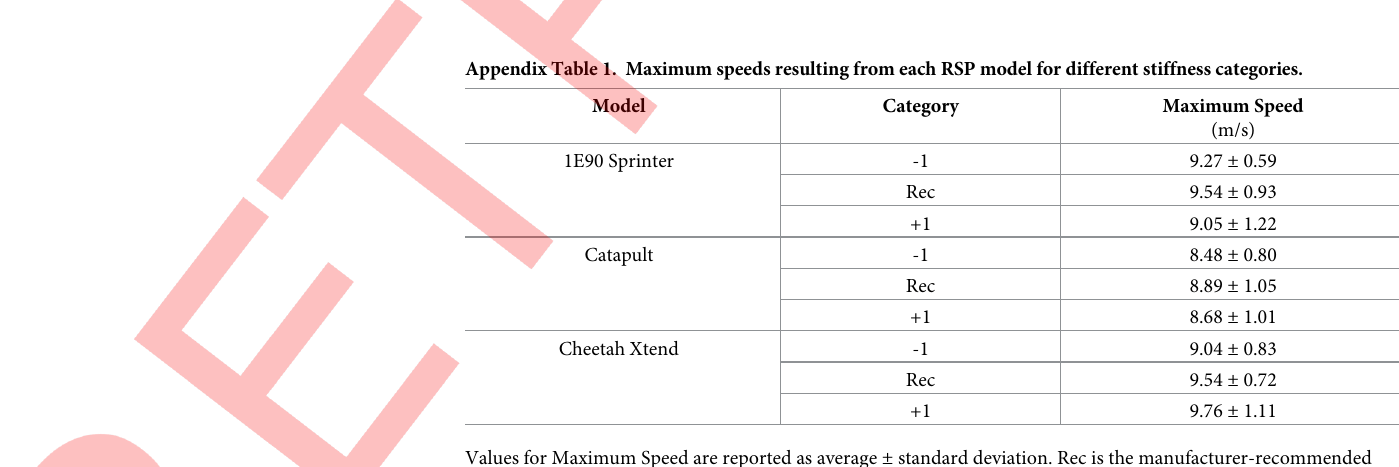
Appendix Table 1. Maximum speeds resulting from each RSP model for different stiffness